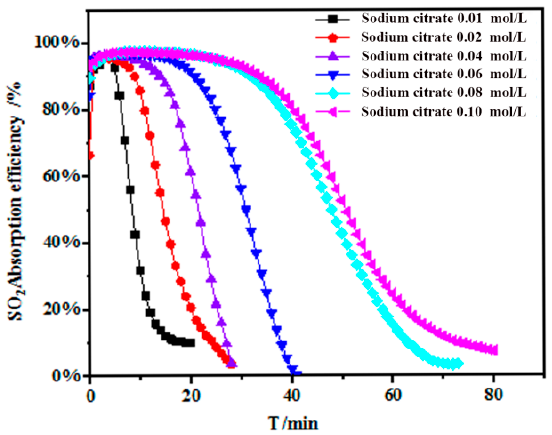
Figure 1. Effect of Ci-Na concentration on desulfurization efficiency. SO 2 = 2300 ppm, gas flow = 1.68 L/min and absorption solution = 60 mL and 25 ° C.